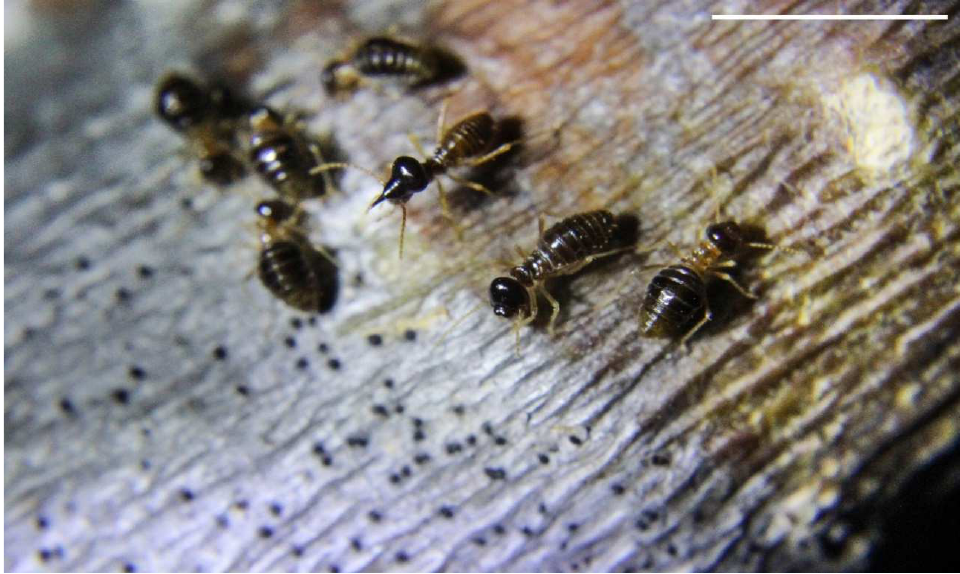
Figure 7. Individuals of Constrictotermes cyphergaster (Blattodea, Termitidae) foraging on lichen. Scale bar = 0.5 cm.